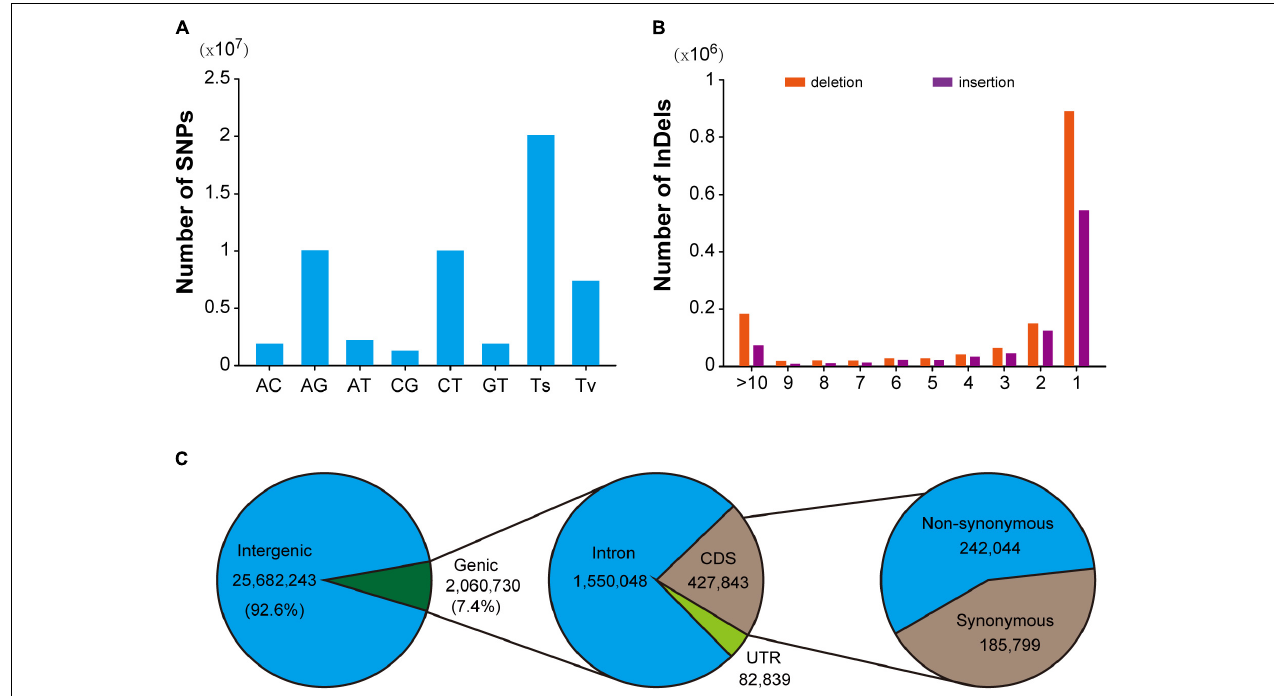
FIGURE 1 | Summary of SNPs and indels detected in the hybrid population. (A) Mutation pattern of SNPs in F1 hybrid population. (B) Distribution pattern of indel length in F1 hybrid. population. (C) Annotation of SNPs identified in hybrid F1